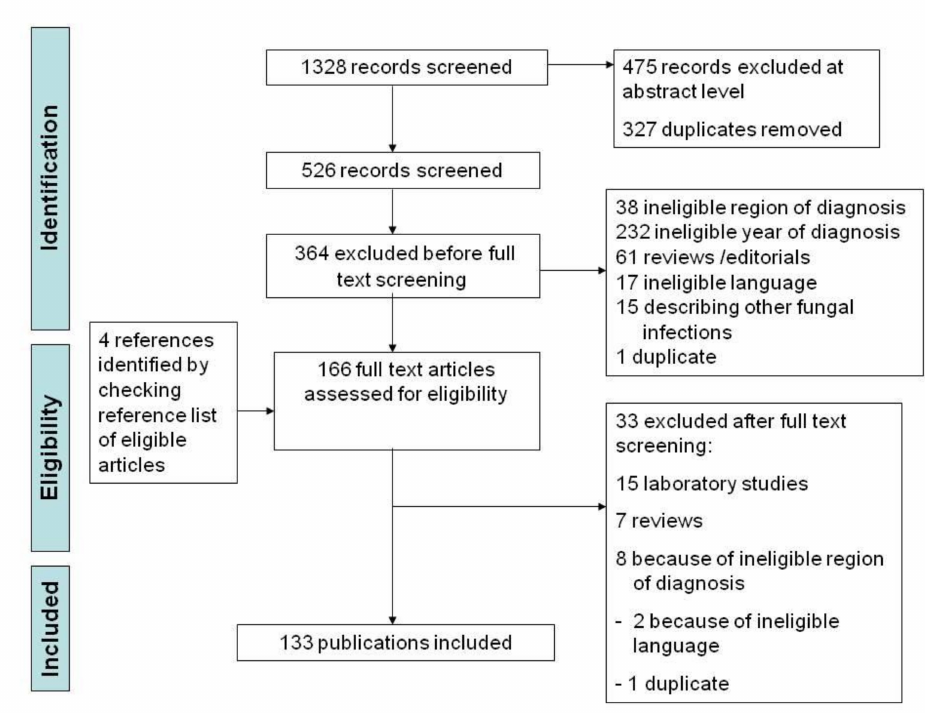
Figure 2. Modified PRISMA flow